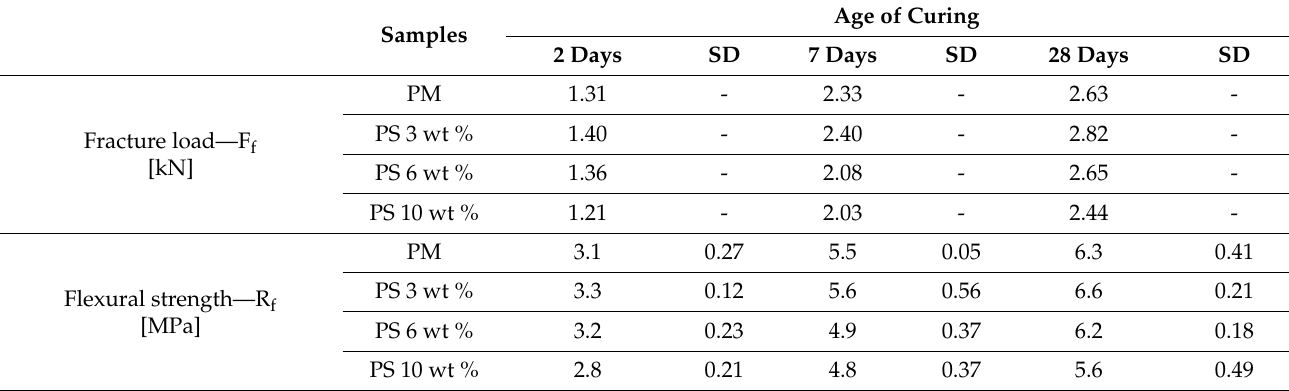
Table 1. Flexural strength ( R f ), fracture load ( F f ), and the standard deviation ( SD ) results for the control sample and